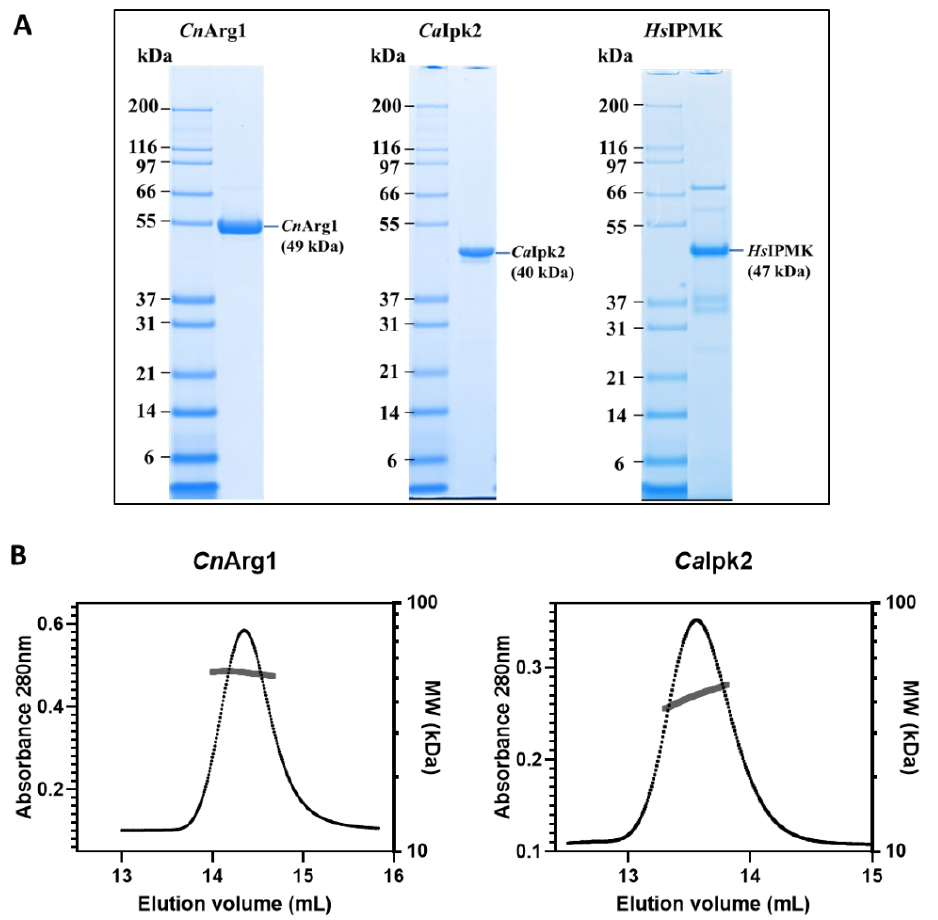
Figure 1. Assessment of purity, size and multimerization state of recombinant fungal IP 3-4 K enzymes. IP 3-4 K cDNA from C. neoformans ( Cn Arg1), C. albicans ( Ca Ipk2) and human ( Hs IPMK) were cloned into the pGEX-6P expression vector and purified using a two-step procedure described in the methods. ( A ) SDS-PAGE was used to assess the size and purity of the recombinant fungal IP 3-4 K enzymes. The theoretical molecular weights (MW) of the fungal enzymes, calculated from their amino acid sequences, are indicated next to the bands. ( B ) SEC-MALLS analysis suggested that Cn Arg1 and Ca Ipk2 are monomeric with calculated molecular weights of 52 kDa and 43 kDa, respectively, in agreement with predicted values of 49 kDa and 40 kDa. The dotted lines represent the UV-profile of the eluted proteins, and the thick grey lines represent the SEC-MALLS-processed MW measurements.